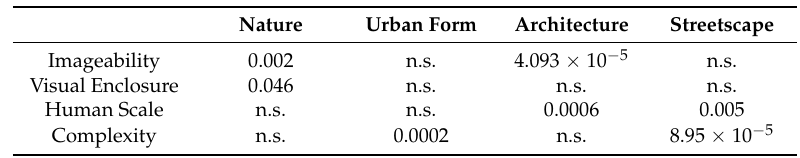
Table 4. Regression statistics of perceptual qualities of a place (and variables forming urban design guidelines).